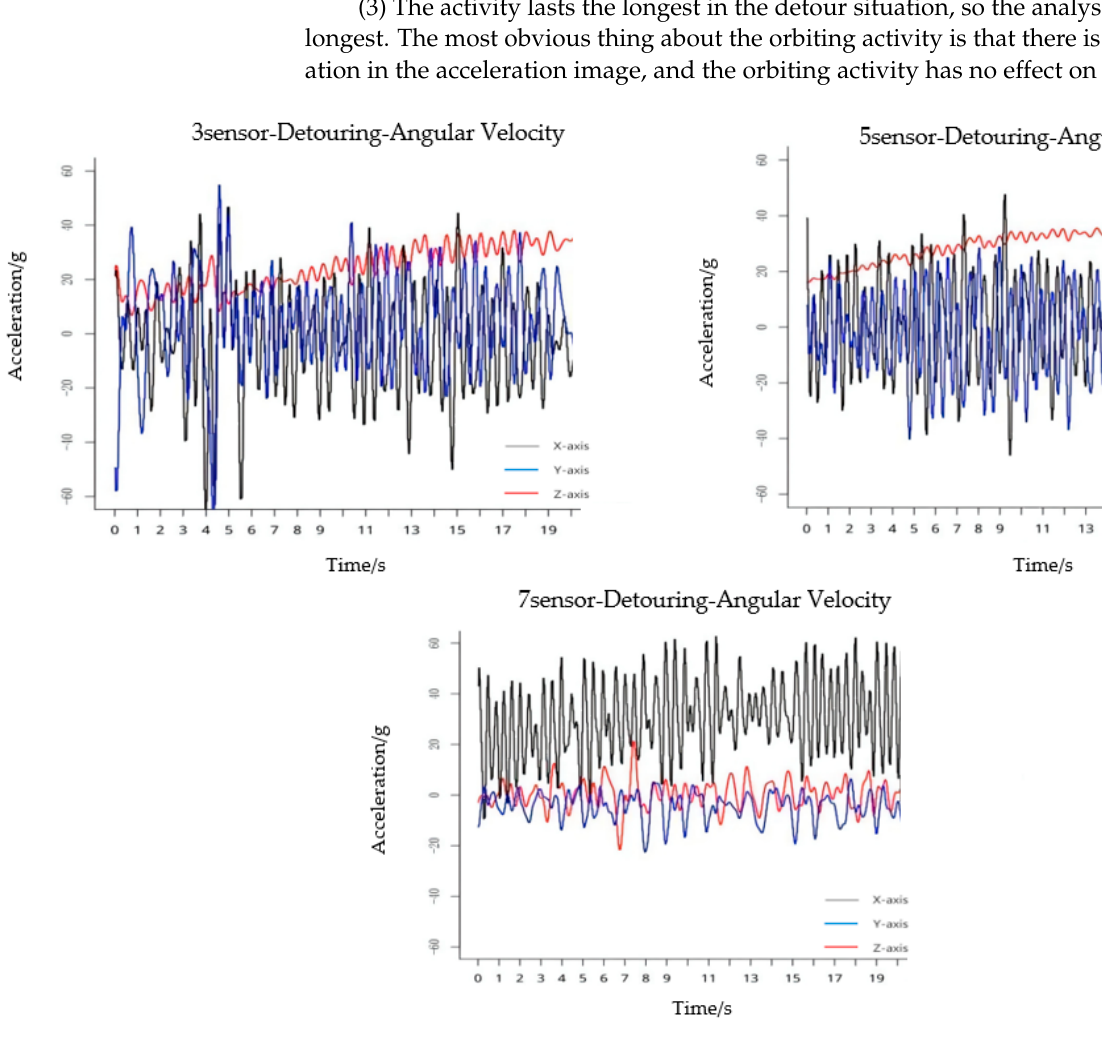
Figure 7. Angular velocity graph during orbiting.